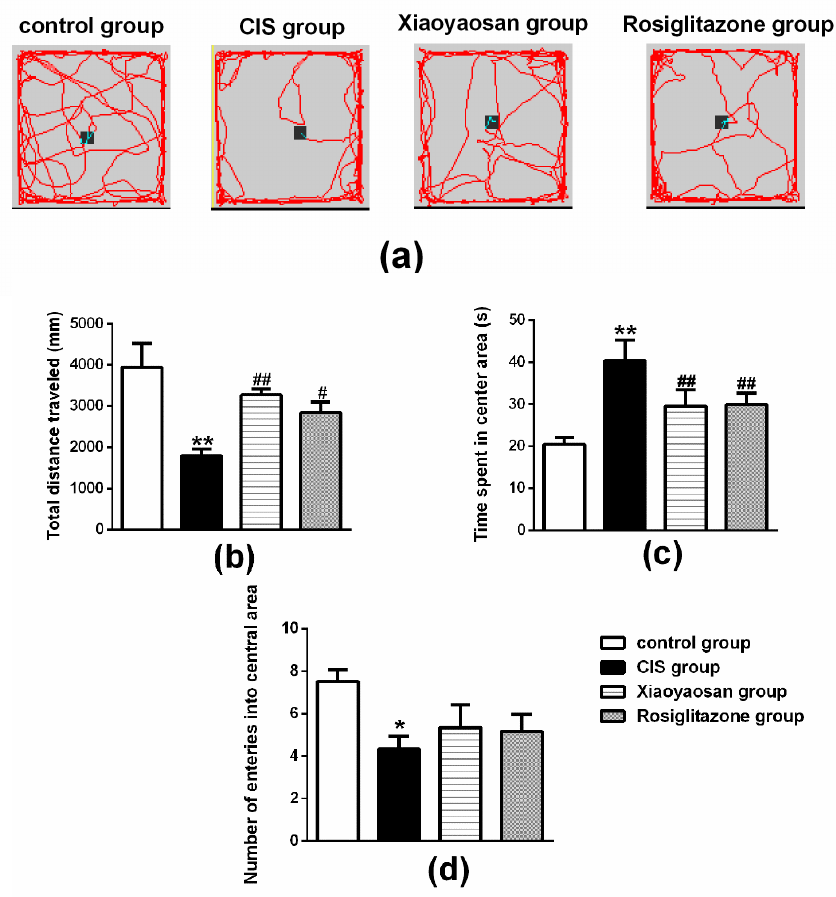
Figure 2. Effects of Xiaoyaosan on stress-induced locomotor activity and exploratory behaviour. ( a ) The track maps of the rats in the different groups in the OFT test. ( b ) Total distance travelled in the OFT. ( c ) The time spent in the centre area of the OFT. ( d ) Number of times the centre area was entered in the OFT. Data are presented as the means ± SEM with 9–10 rats in each group. * p < 0.05 or ** p < 0.01 versus the control group. # p < 0.05 or ## p < 0.01 versus the CIS group.